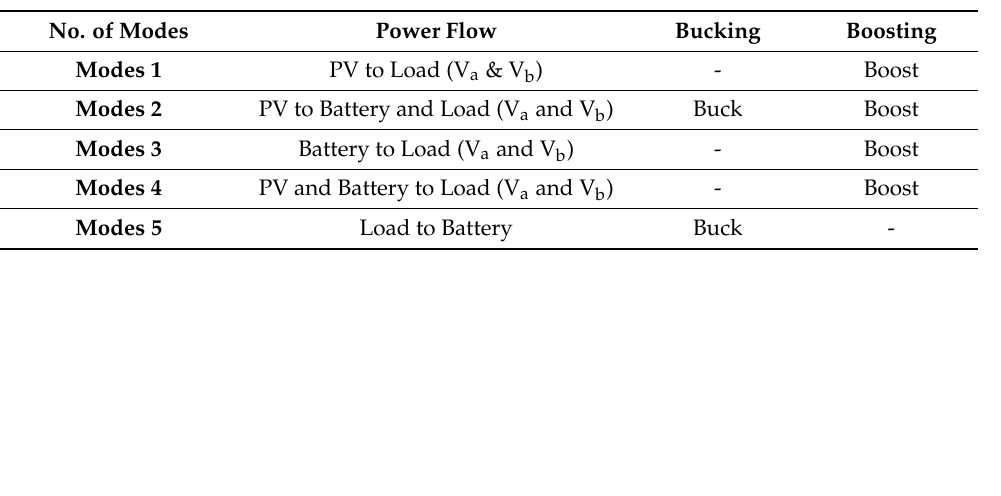
Table 3. Summary of operation modes in MPC